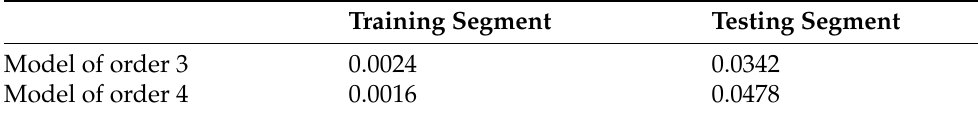
Figure 7. Orders 3 and 4, all 11 variables. Table 6. NRMSE errors for respective model orders and 11 variables.